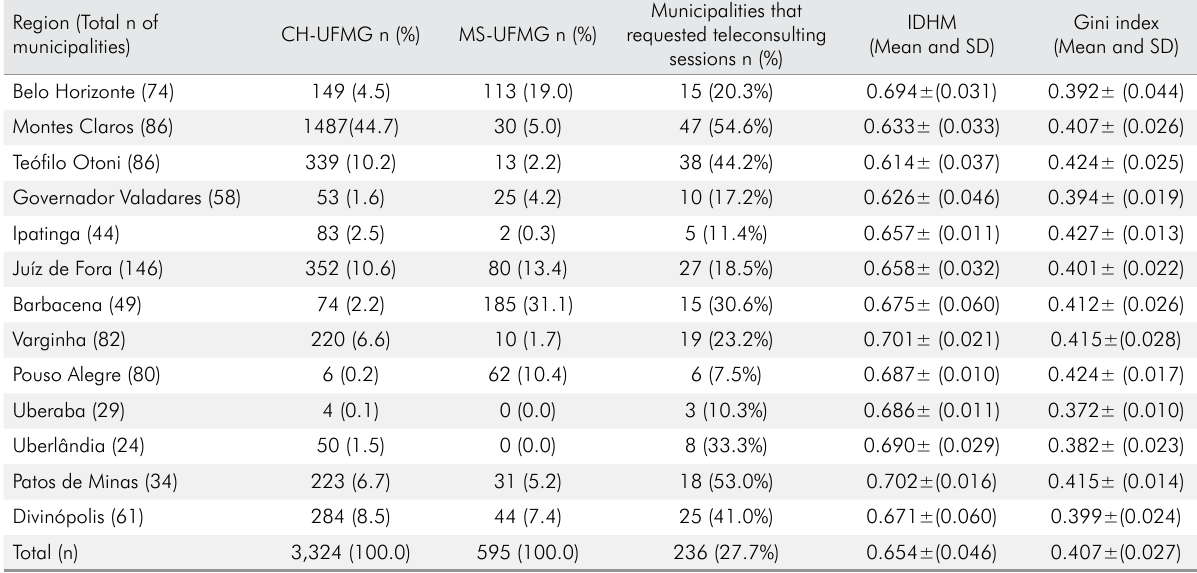
Table 2. Descriptive analysis of the Intermediate Geographical Region of Minas Gerais that requested teleconsulting and the absolute and relative frequency of requests according to the Telehealth center in Minas Gerais, Brazil, 2017.